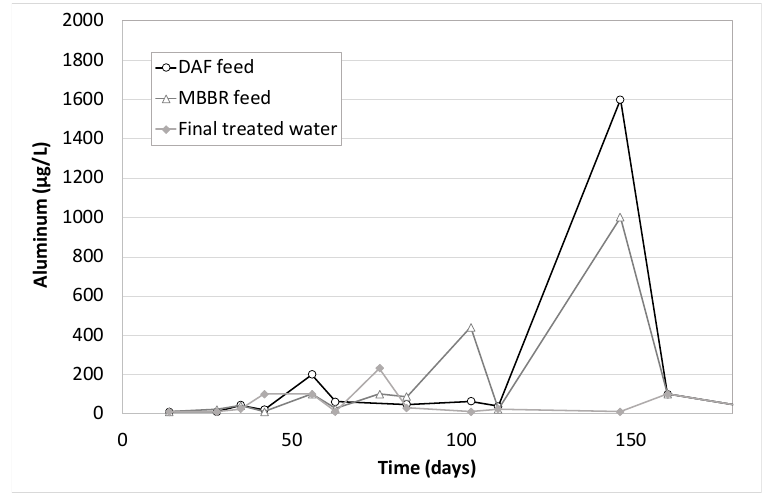
Figure 19. Aluminum concentration along the pilot unit versus time of operation.